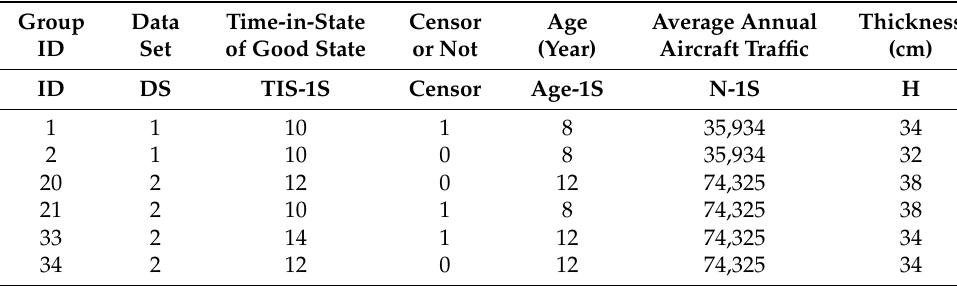
Table 2. Partial data source of airport pavement.